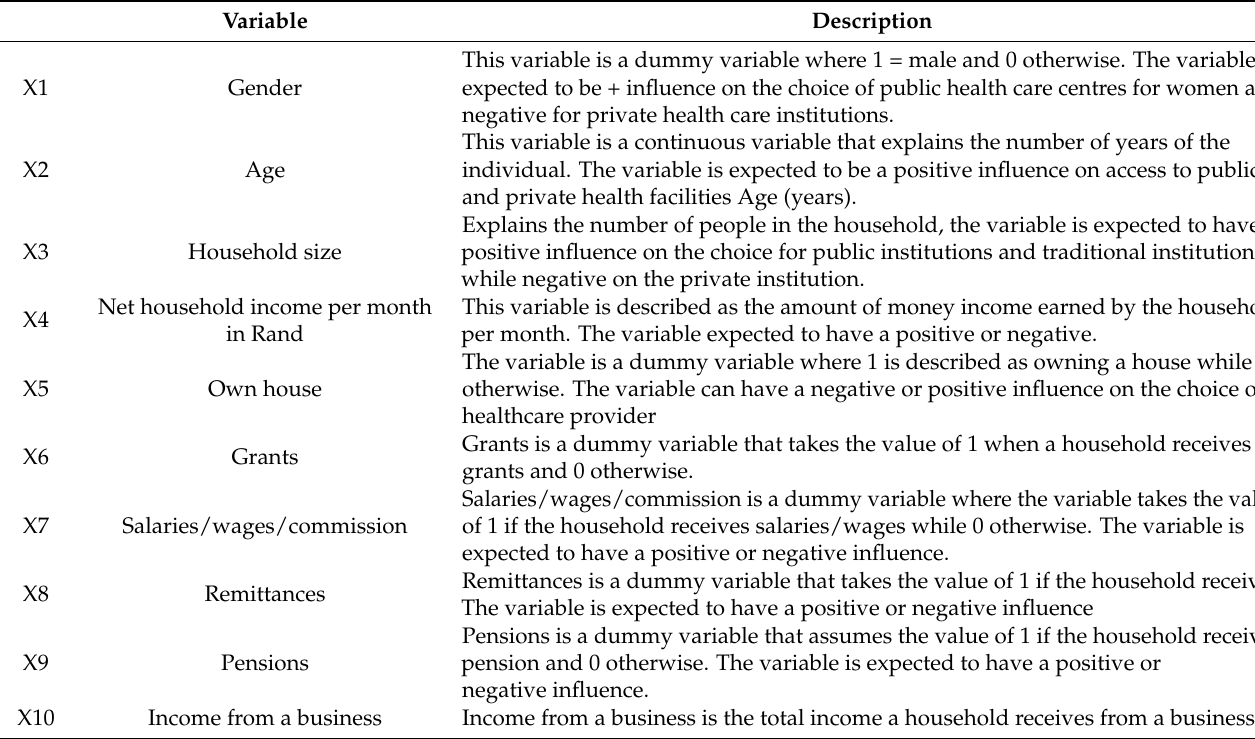
Table 1. Description of independent variables used in the